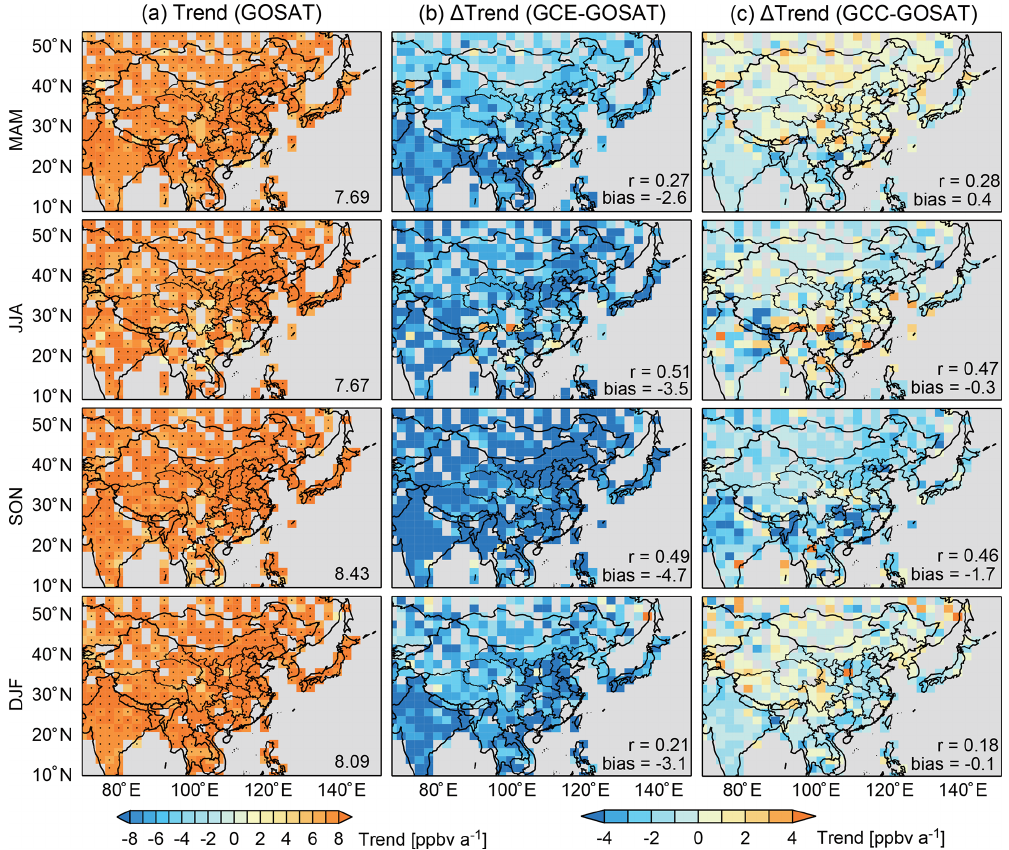
Figure 8. The same as Fig. 7 but for seasonal mean trends in atmospheric CH 4 mixing ratios over 2010–2017. The middle and right panels show, respectively, GCE (with EDGAR anthropogenic emissions and interannually varying OH; column b ) minus GOSAT (column a ) and GCC (with CEDS and interannually varying OH; column c ) minus GOSAT differences. The observed mean CH 4 concentration trend, GOSAT vs. model correlation coefficients ( r ), and mean model biases over China are shown inset.